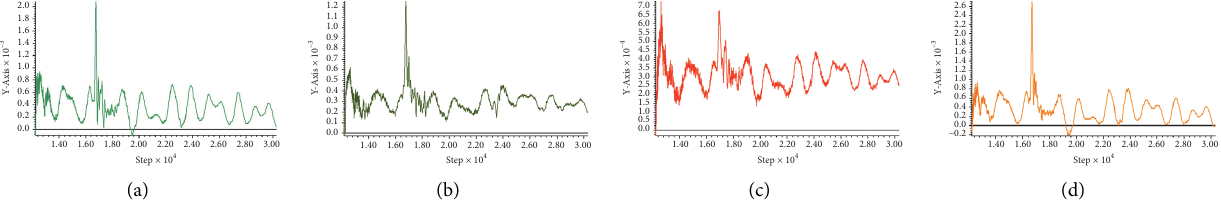
Figure 14: The vibration speed changes when the roadway moves vertically for 10: (a) roof, (b) floor, (c) left side, and (d) right side.